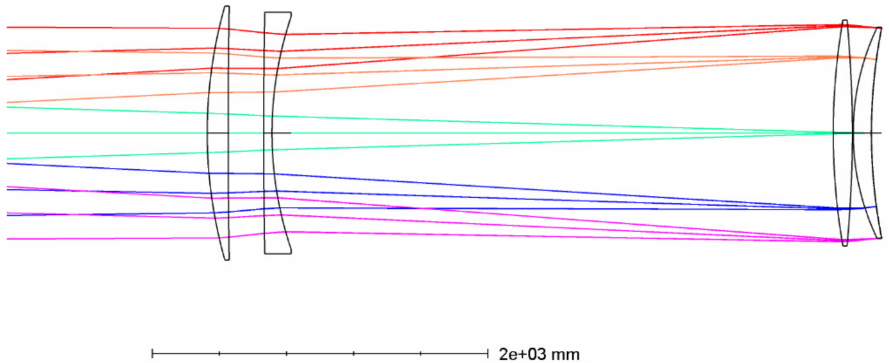
Figure 5. All fused-silica CL-ADC design proposed as an alternative to the baseline C-ADC design for GMT by Saunders et al. Elements 1 to 4 are numbered from left to right.